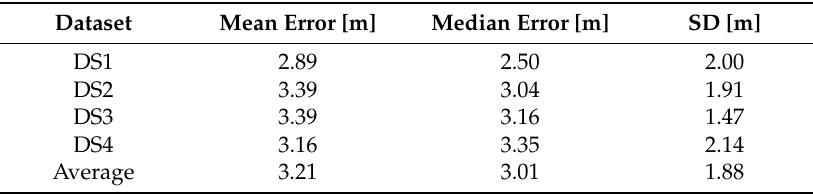
Table 2. Comparison of the mean and median errors made by MFAM utilizing HomeMatic (868 MHz)